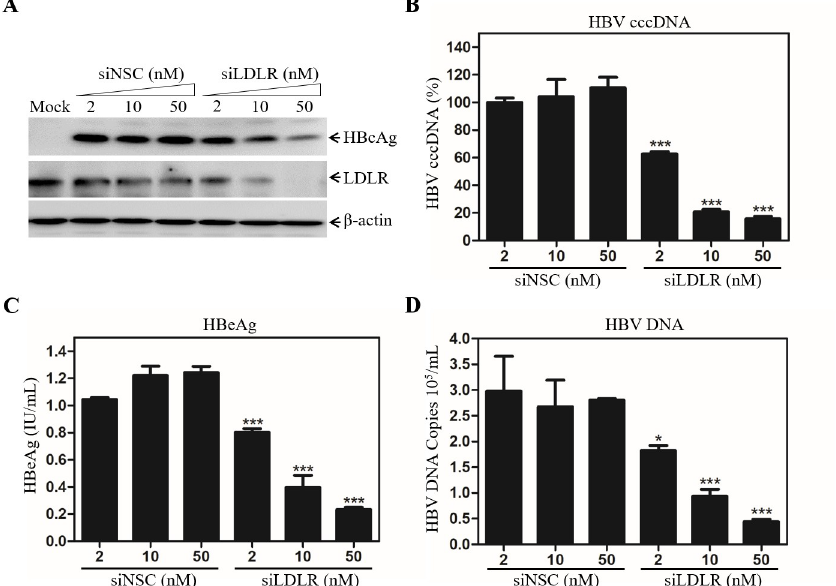
Fig 4. Reduction of HBV infection by LDLR-specific siRNAs. HepG2 NTCP cells were transfected with a Smartpool of LDLR-specific siRNAs at varying concentrations (0, 2, 10, 50 nM) using RNAiMax (Invitrogen) as described in our previous work [22]. A non-specific control siRNA (siNSC) was used as a control. At 2-days post-transfection (p.t.), cells were infected with HBV in the presence of 4% PEG at 37˚C for 12 hrs. At 4-days p.i., the levels of LDLR and HBcAg in the cell were determined by Western blot using specific antibodies ( A ). HBV cccDNA in cells was extracted and quantified by a Real-Time PCR method ( B ), as described previously [22]. The levels of HBeAg in the supernatants were measured by a chemiluminescence immunoassay ( C ). The levels of HBV DNA in the supernatants were quantified by a Real-Time PCR method ( D ). Average values of triplicates were calculated and plotted against siRNAs concentrations. � P < 0.05, ��� P <